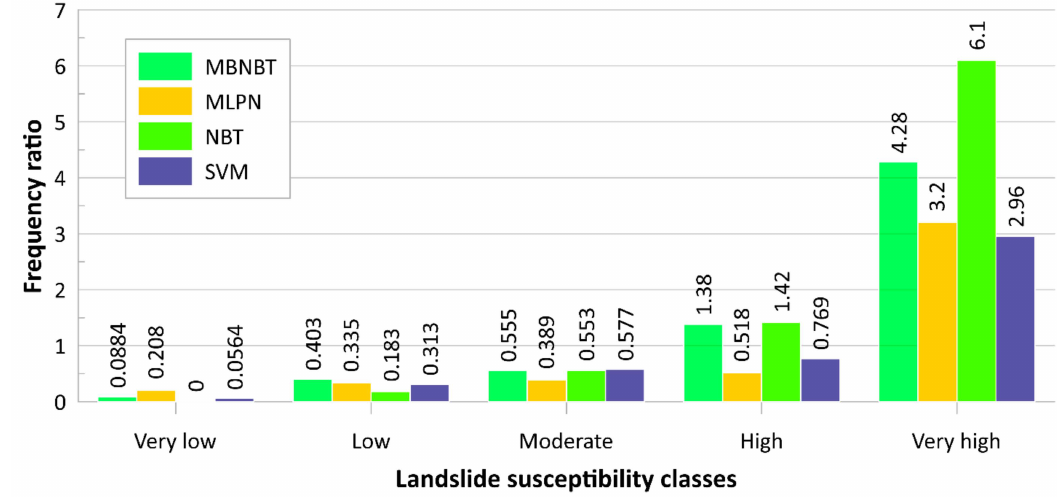
Figure 10. Frequency ratio result of the four machine learning methods (MBNBT, MLPN, NBT, and SVM).